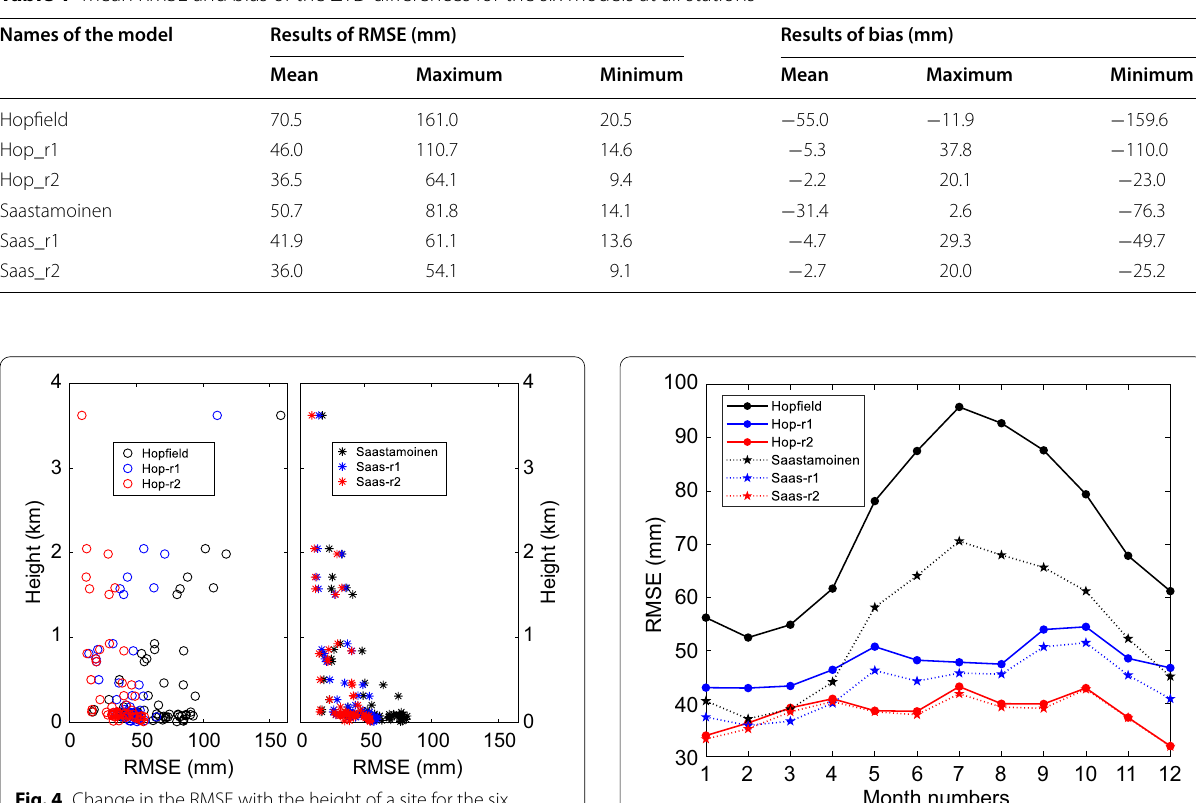
Fig. 4 Change in the RMSE with the height of a site for the six models